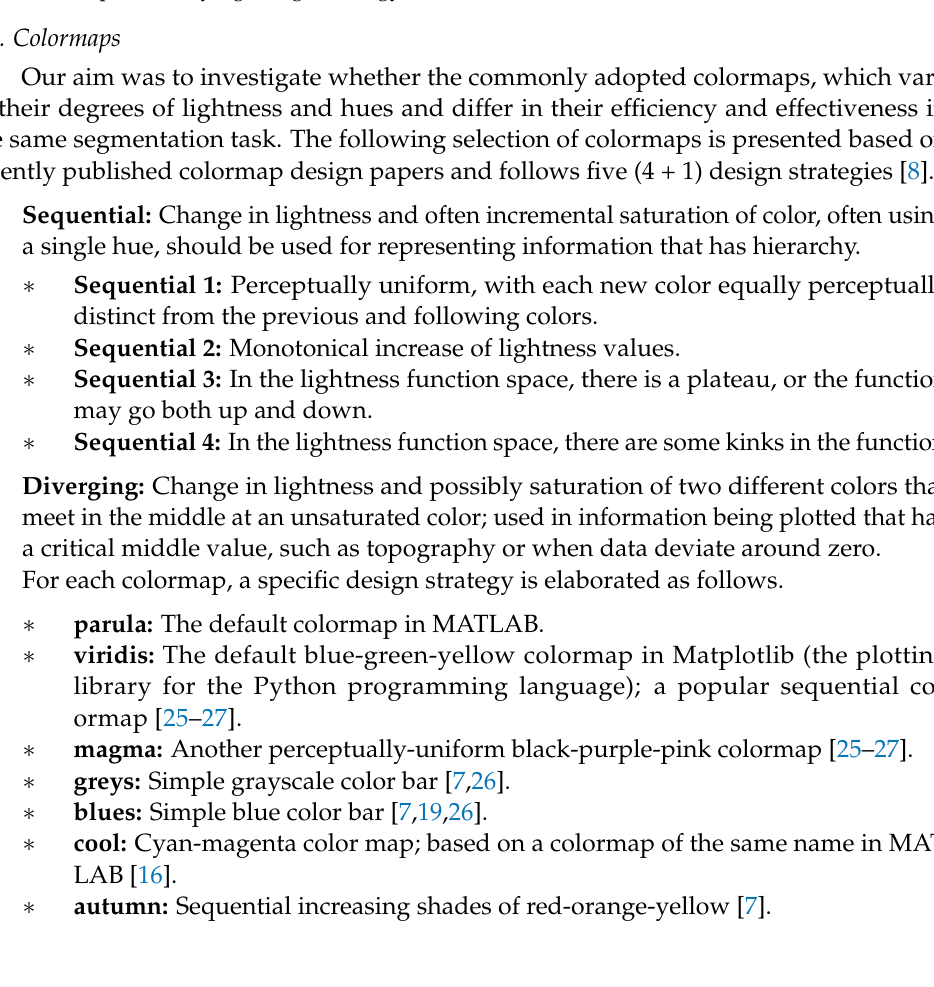
Figure 3. The 11 colormaps we studied with their hues and lightness characteristics, followed by each colormap’s underlying design strategy